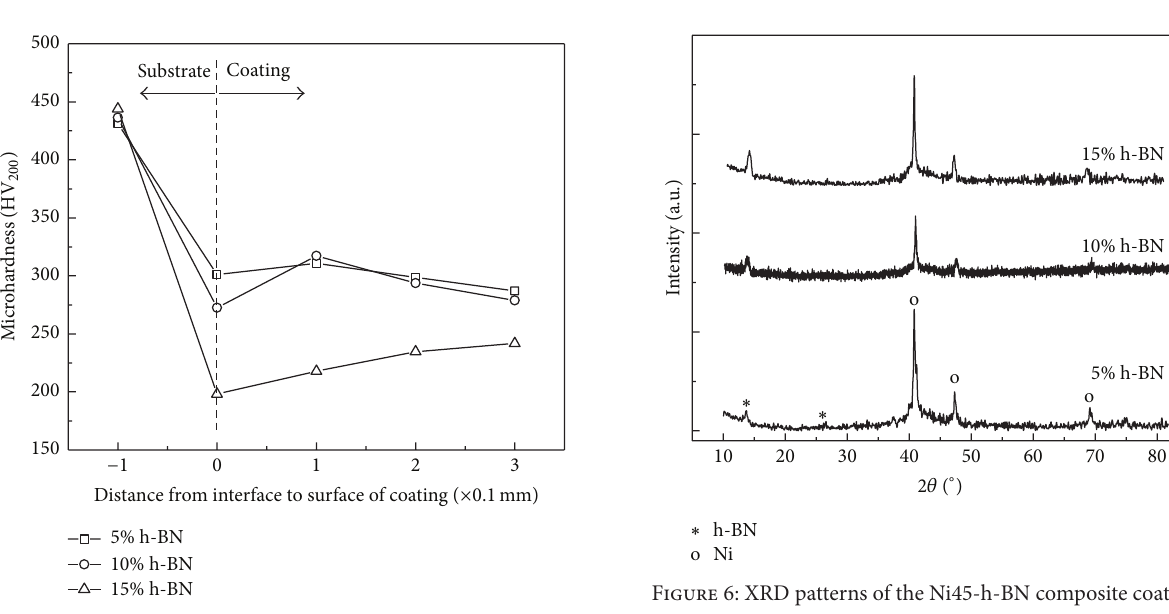
for Ni45-h-BN composite coatings with the component of 5 wt.%, 10 wt.%, and 15 wt.% h-BN, the fracture load reached 4.2 kN, 2.7 kN, and 1.5 kN, converting into tensile stress that was equivalent to 23.83 MPa, 15.08 MPa, and 8.3